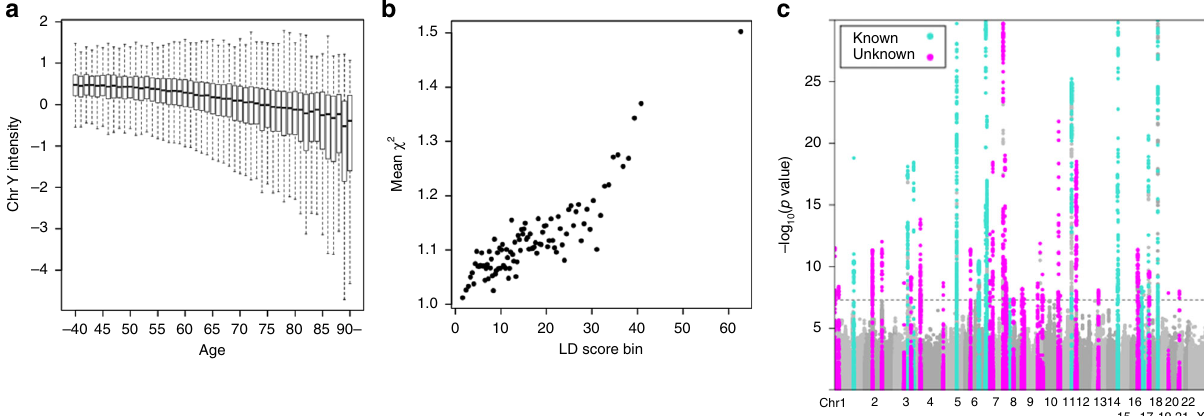
Fig. 1 Associations of Chromosome Y signals with old age and a total of 50 genetic determinants in mLOY. a An association between mLOY and age at blood collection is indicated. We do not show outliers in the fi gure. Bars indicate the most extreme data points which are no more than 1.5 times interquartile ranges from the boxes. b Polygenetic architecture in mLOY. Mean chi-square statistics and LD scores in 100 bins of Hapmap project variants in mLOY are indicated. Bins are made according to LD scores to contain almost equal number of variants in each bin. c Manhattan plot of mLOY in this study. Green and red colors indicate previously reported and unreported regions, respectively. Only P -values >1.0 × 10 − 30 are